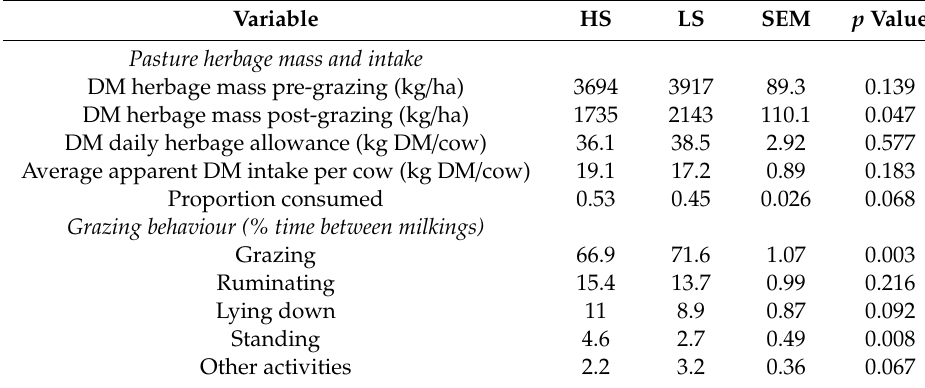
Table 2. Herbage mass (pre- and post-grazing), average herbage allowance, apparent dry matter (DM) intake, and behaviour of dairy cows grazing on a perennial ryegrass pasture with high (32.2% DM, HS) and low (22.4% DM, LS) contents of water-soluble